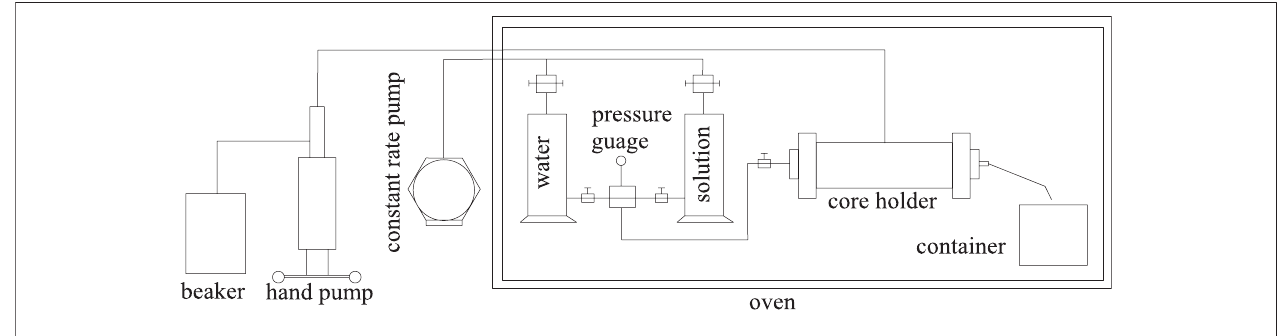
FIGURE 4 | Core fl ooding experiment